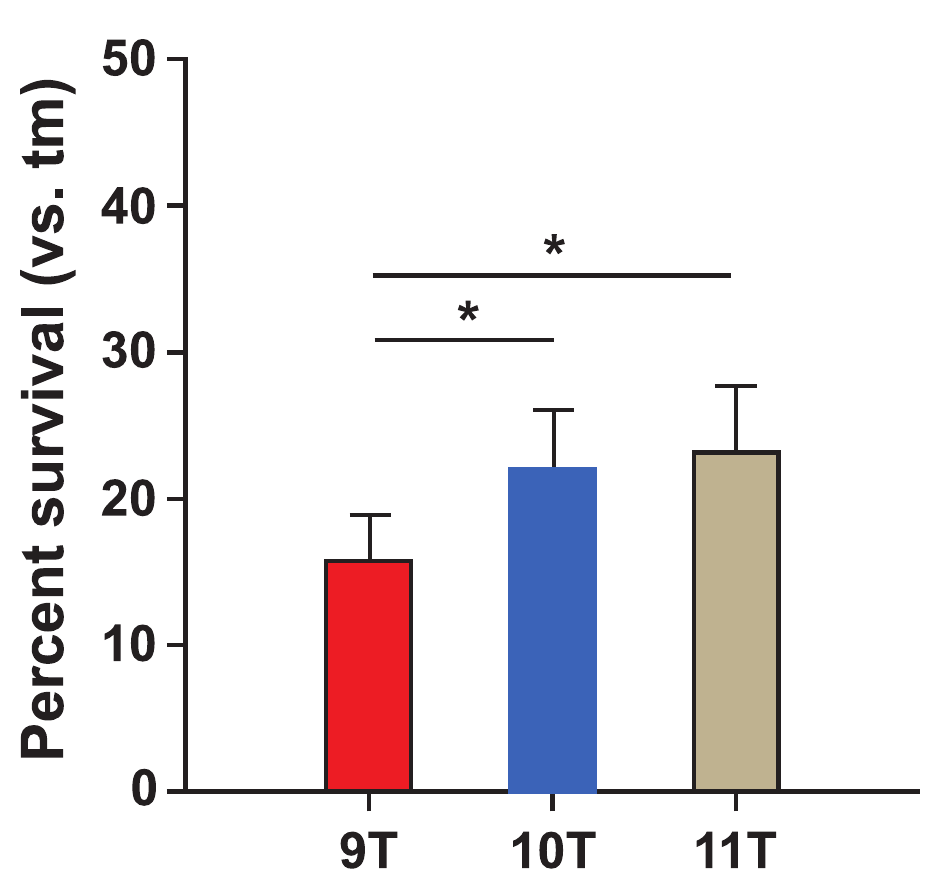
Fig 9. Resistance to killing by human PMNs. Survival of 3 variant HT Spy1336-7 isogenic strains in the presence of purified human PMNs. Bacterial survival data are expressed as the mean ± SEM. � P < 0.05 using a repeated-measures one-way ANOVA and Tukey’s posttest ( n = 7 experiments). tm, time-matched control lacking